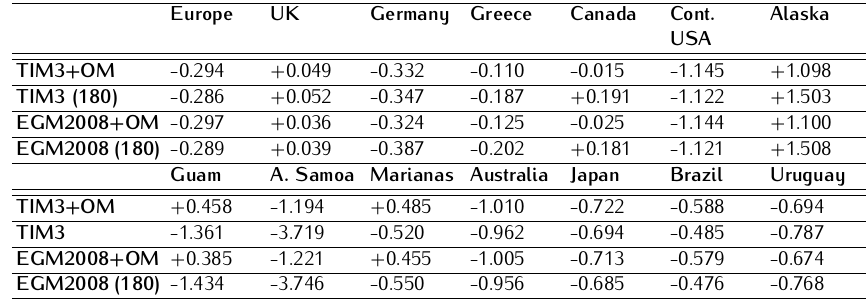
Table 3. Local geoid offset with respect to TIM3 GOCE and EGM2008 geoid (up to degree and order 180) per region applying Eq. (3) . TIM3+OM: TIM3geoidincludingestimatedomissionerrorfromEGM2008(plusRTMforGermany); TIM3: pureTIM3geoidwithouttakingintoaccount the omission error. EGM2008+OM: EGM2008 geoid from complete series; EGM2008(180): EGM2008 geoid truncated at degree 180. All mean differences in